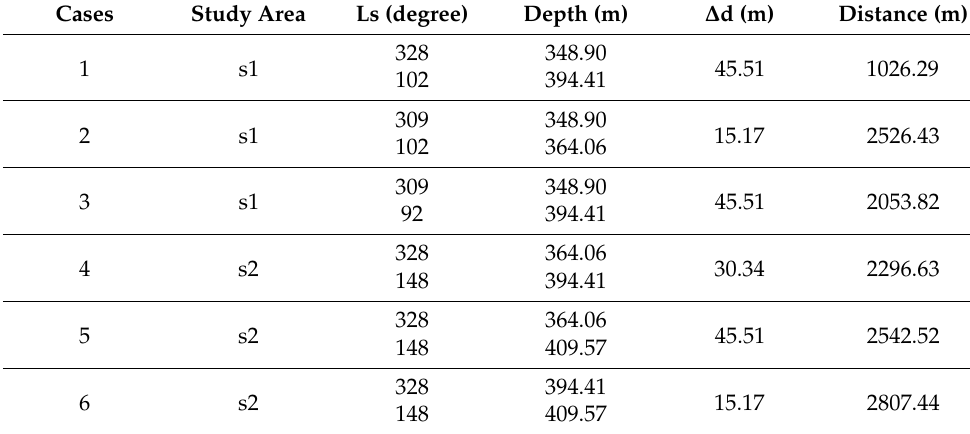
Table 3. Six cases of SHARAD observations in different Martian seasons. Ls: solar longitude; Depth: the position of the lower interface of AA 3c ; Distance: subsatellite distance between two nodes.